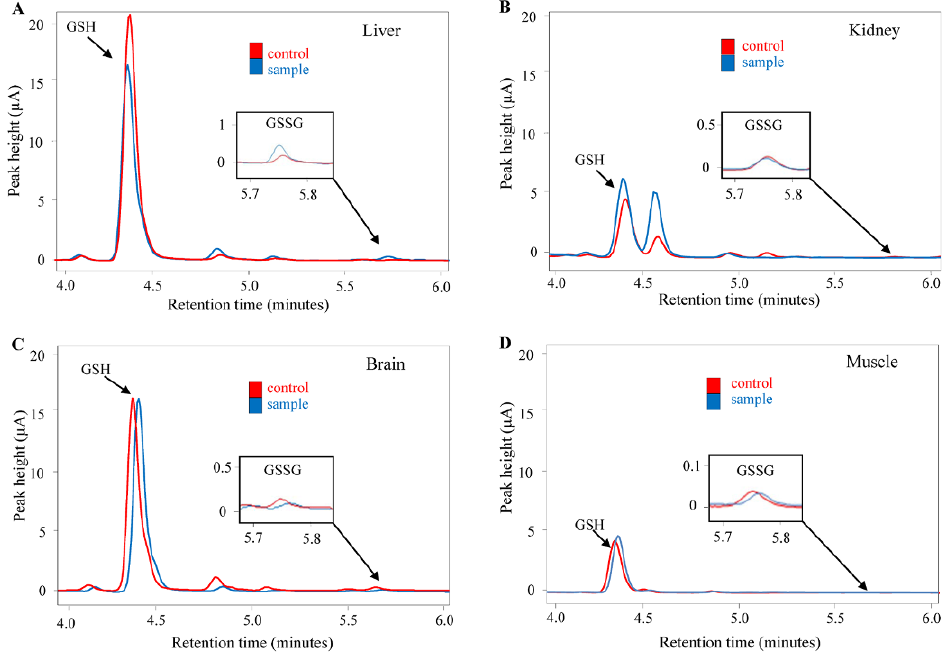
Figure 1. Overlay of chromatograms of control and real sample from variant 1000% inorganic after 22 days for ( A ) liver, ( B ) kidney, ( C ) brain and ( D ) muscle. For other experimental details of chromatographic measurements, see Chapter